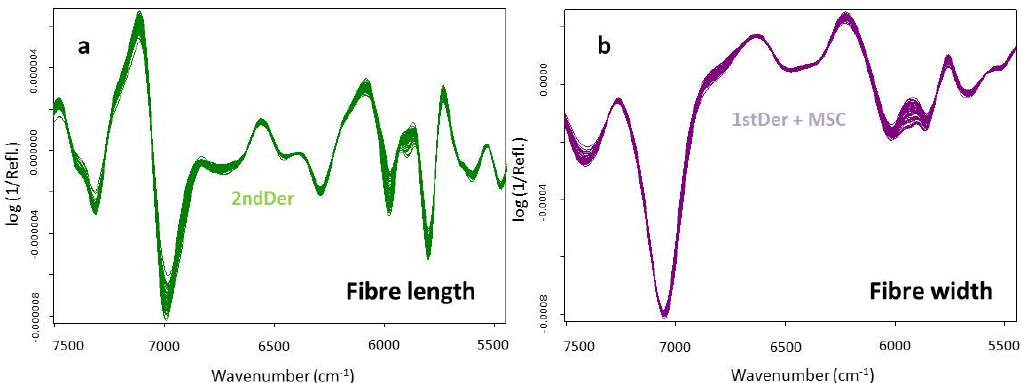
Figure 2. NIR diffuse reflectance for all spectra (45 samples—cross-validation) of the fiber length and fiber width for Acacia melanoxylon pulps ( a , b , respectively).